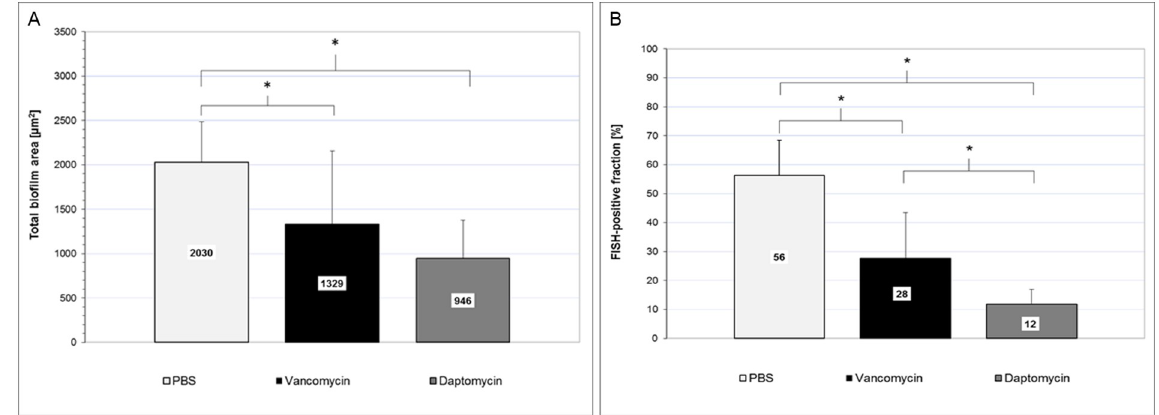
Fig 2. Reduction of the total biofilm mass (A) and FISH-positive fraction (B) in biofilms under antibiotic treatment. Total biofilm area [ μ m 2 ] represented by the DAPI mask in daime and fraction of FISH-positive cells in [%] as compared to the total biofilm area, for in vitro